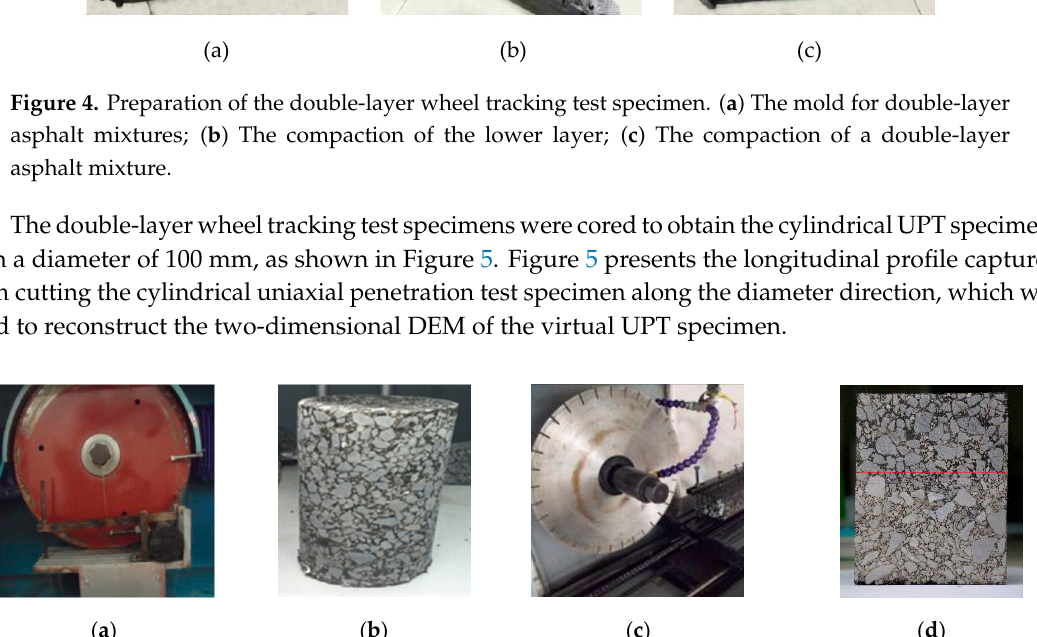
Figure 5. Longitudinal profile acquisition of the uniaxial penetration test specimen. ( a ) The coring machine; ( b ) The UPT specimen; ( c ) The cutting machine; ( d ) The longitudinal profile.